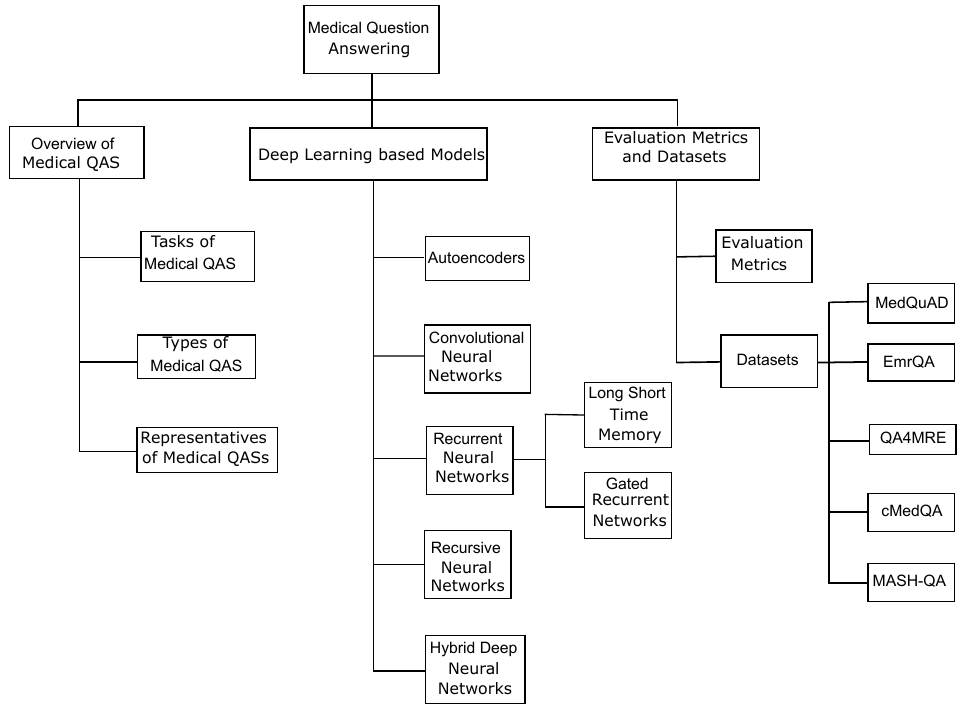
Figure 1. Hierarchical structure of this